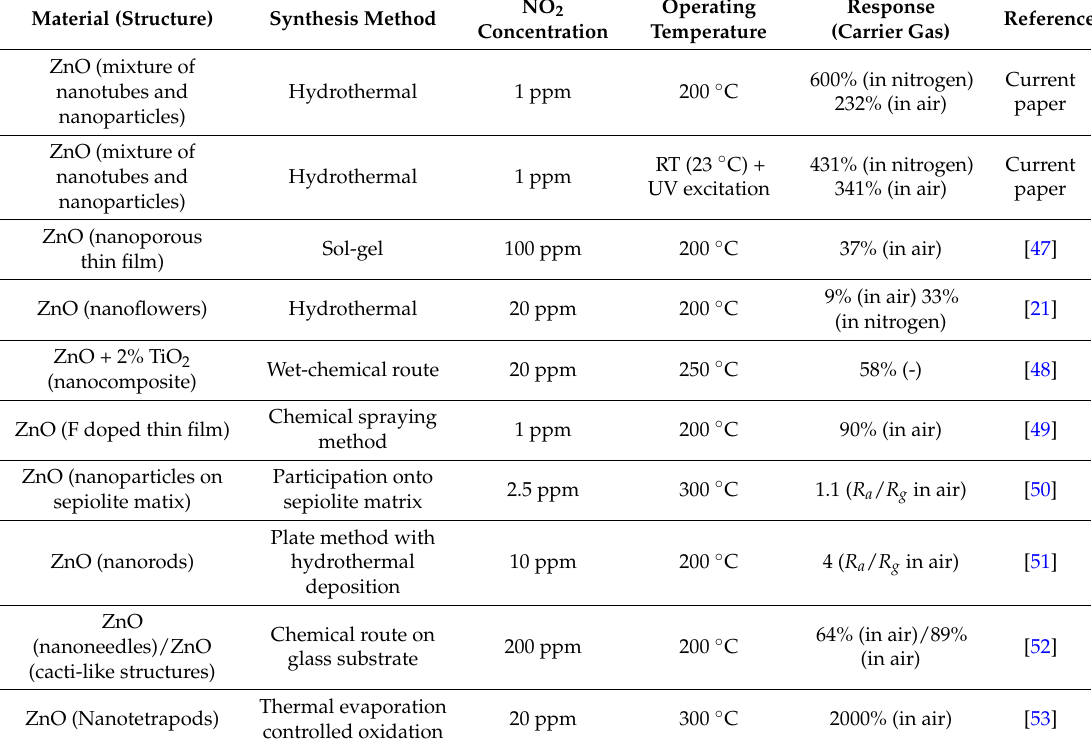
Table 1. Comparison of responses of ZnO nanostructure based NO 2 sensors with investigated ZnO